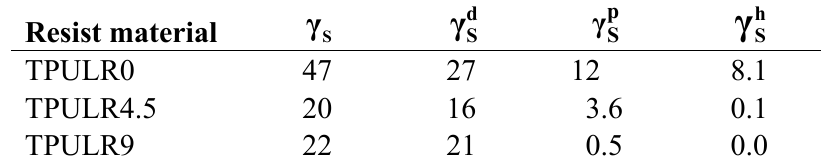
Table 3. Surface free energy components of TPULR9, TPULR4.5, and